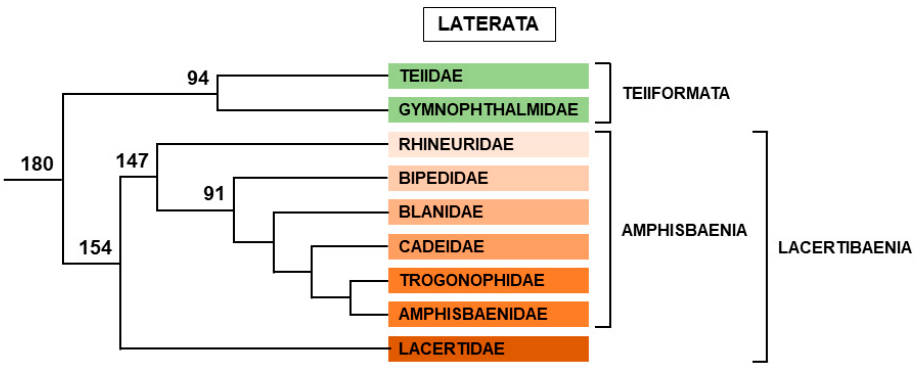
Figure 12. Phylogenic tree of Laterata. Relative positions of each family are represented. Branch lengths are not proportional to time. Numbers indicate divergence time (Myrs) from present for nodes, according to [38]. Color of each family or subfamily indicates the different clades.